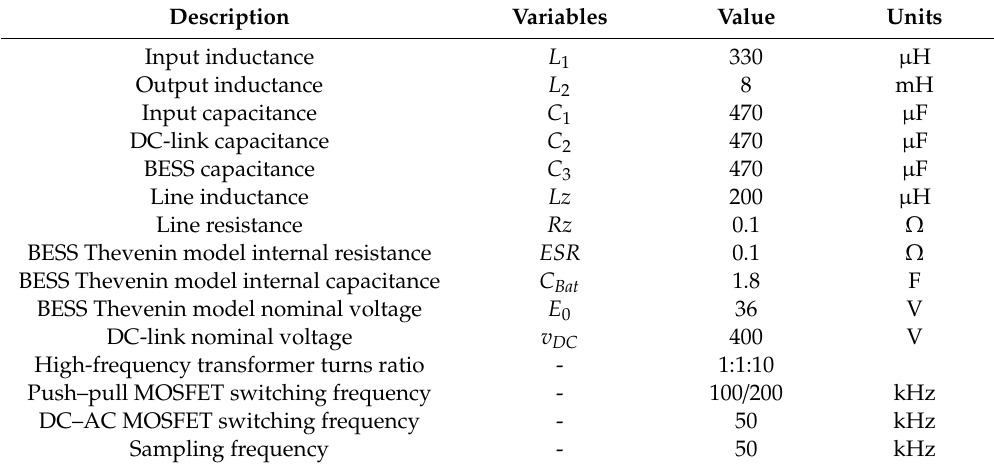
Table 2. Specification of the simulation parameters.